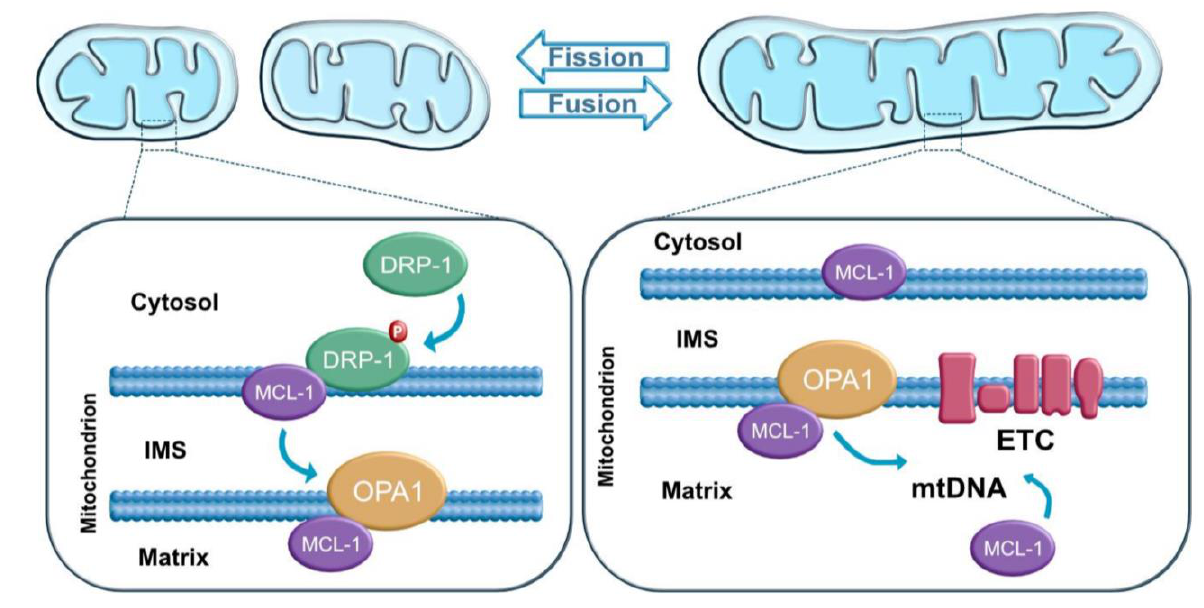
FIGURE 4: Mitochondrial dynamics. Mitochondrial fusion and fission are regulated by guanosine triphosphatases (GTPases) proteins: DRP1 mediates fission, OPA1 and Mitofusins (not shown) regulate mitochondrial fusion. In stem cells, the anti-apoptotic protein MCL1 has been shown to interact with DRP1 at the outer mitochondrial membrane and with OPA1 at the